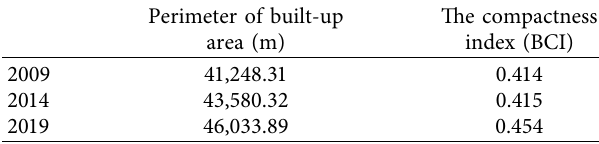
Table 3: Land-use compactness index of Ciyutuo Subdistrict.